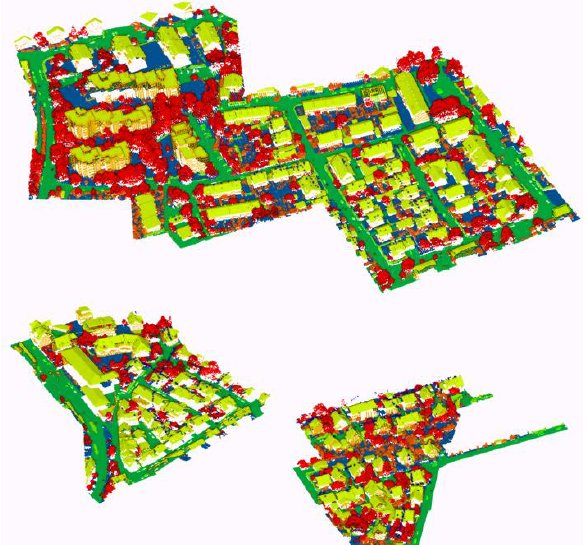
Figure 4. Labelled training (above) and evaluation data (below) over Vaihingen (Germany). Each of the 9 classes is labelled with a different colour. 3D Region Growing Segmentation: For our